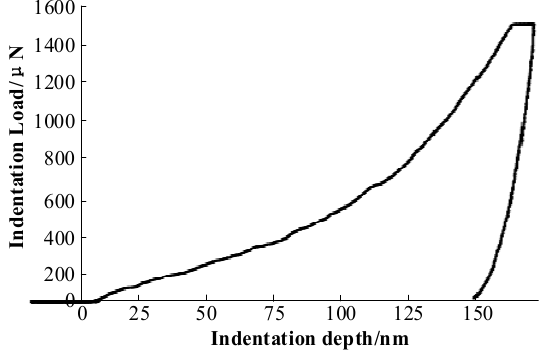
Figure 4. Test results of loading and unloading curves of Nano-indentation.